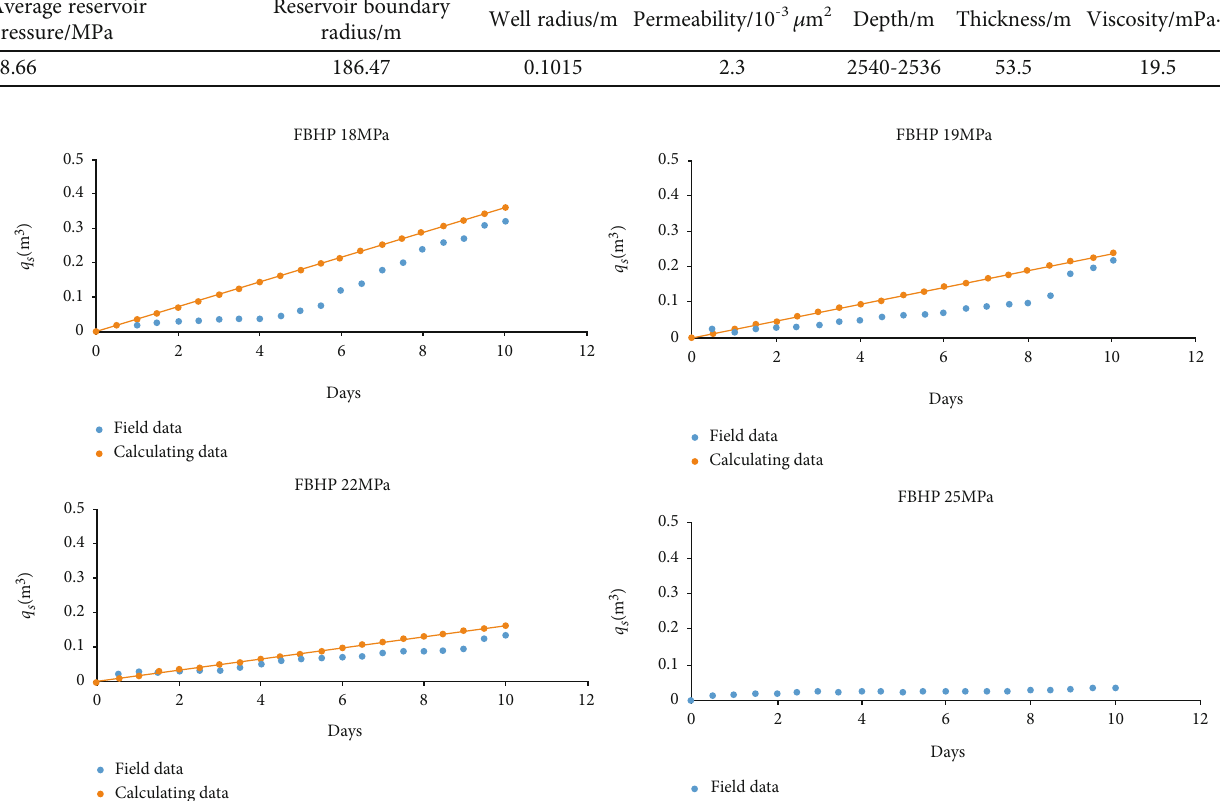
Table 1: Petrophysical parameters of the Daqing oil fi eld.